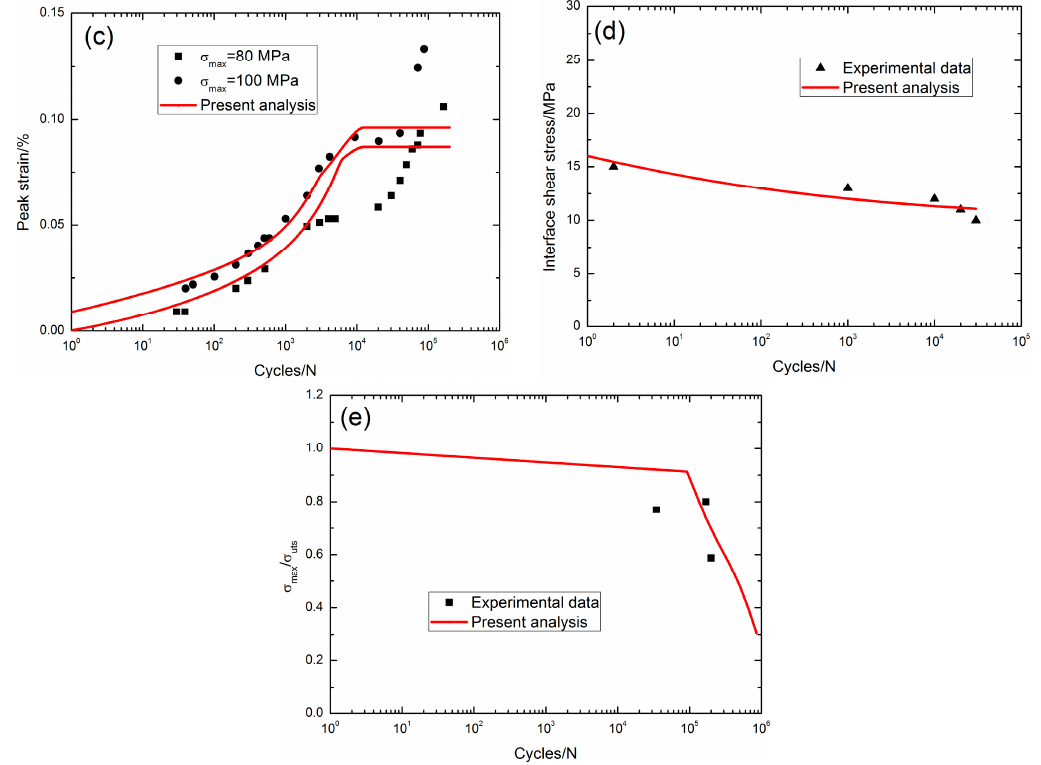
Figure 3. ( a ) The fatigue hysteresis dissipated energy versus applied cycles; ( b ) the normalized hysteresis modulus versus applied cycles; ( c ) the peak strain versus applied cycles; ( d ) the interface shear stress versus applied cycles; and ( e ) the fatigue life S-N curves of 2D SiC/SiC composite at 1000 °C in air [3].